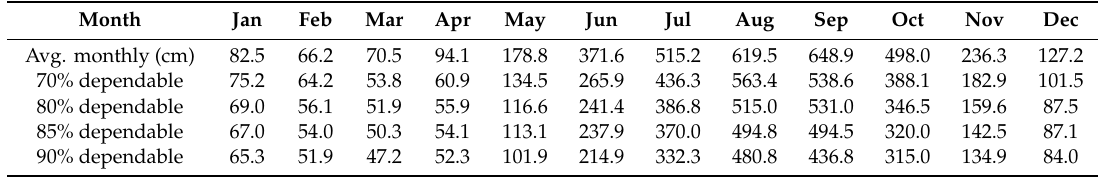
Table 4. Result of the flow duration curve analysis under di ff erent